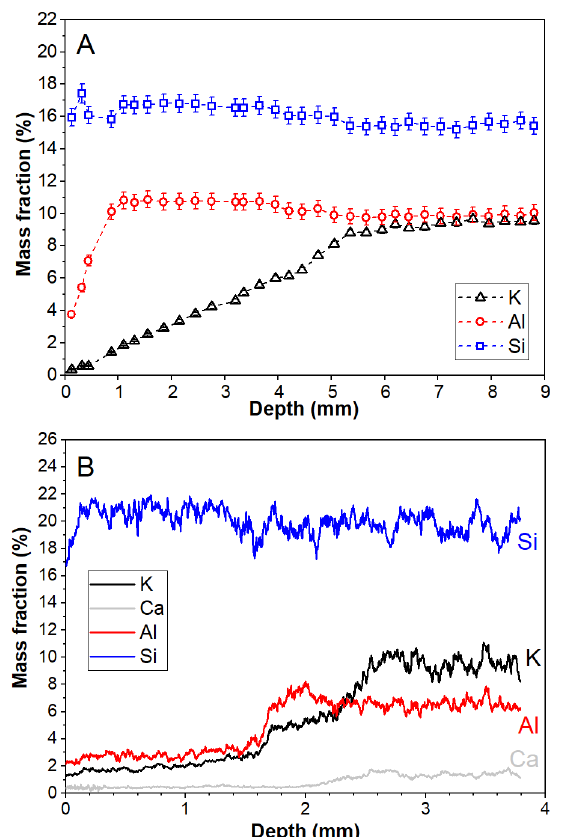
Figure 1. (A) Semi ‐ quantitative concentration profiles [obtained by integrating energy ‐ dispersive X ‐ ray spectroscopy (EDS) mapping data] of K, Al and Si in a metakaolin ‐ based AAM after exposure to acetic acid; the acid ‐ exposed surface is shown left (depth = 0 mm). The respective depths to which K and Al are leached differ. (Data from [18].) (B) Concentration profiles [obtained by integrating wavelength ‐ dispersive X ‐ ray spectroscopy (WDS) mapping data] of K, Ca, Al and Si in a metakaolin ‐ based AAM after exposure to biogenic sulfuric acid in a sewer system. The respective depths to which K and Al are leached differ. (Data from